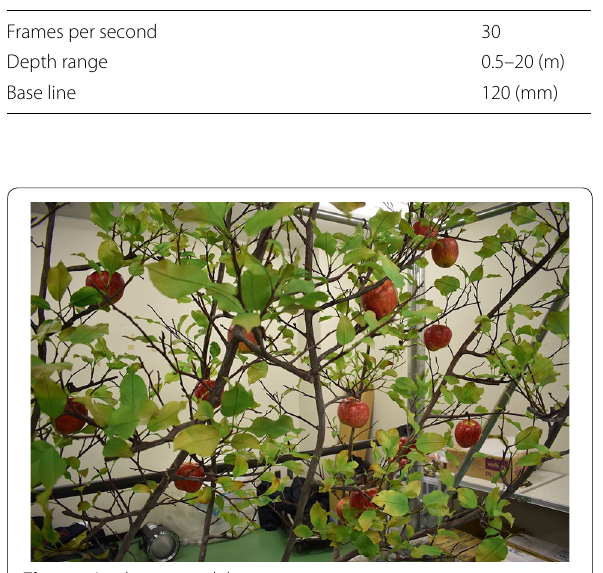
Fig. 11 Apple tree model